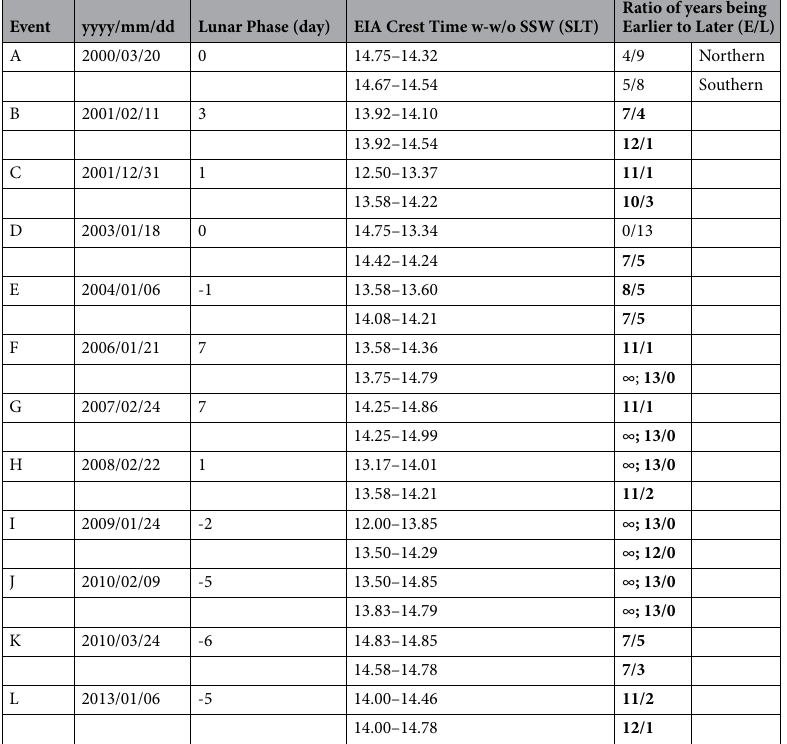
Table 1. SSW Events during 2000–2013. Bold character stands for that the ratio of years being earlier to later (E/L) is greater than 1. Day 0 stands for the new or full moon day, where a minus “−” sign means the event occurs before that day. The EIA Crest Time of w/o SSW is averaged over the corresponding days of the other 13 w/o SSW years (i.e., total w/o SSW